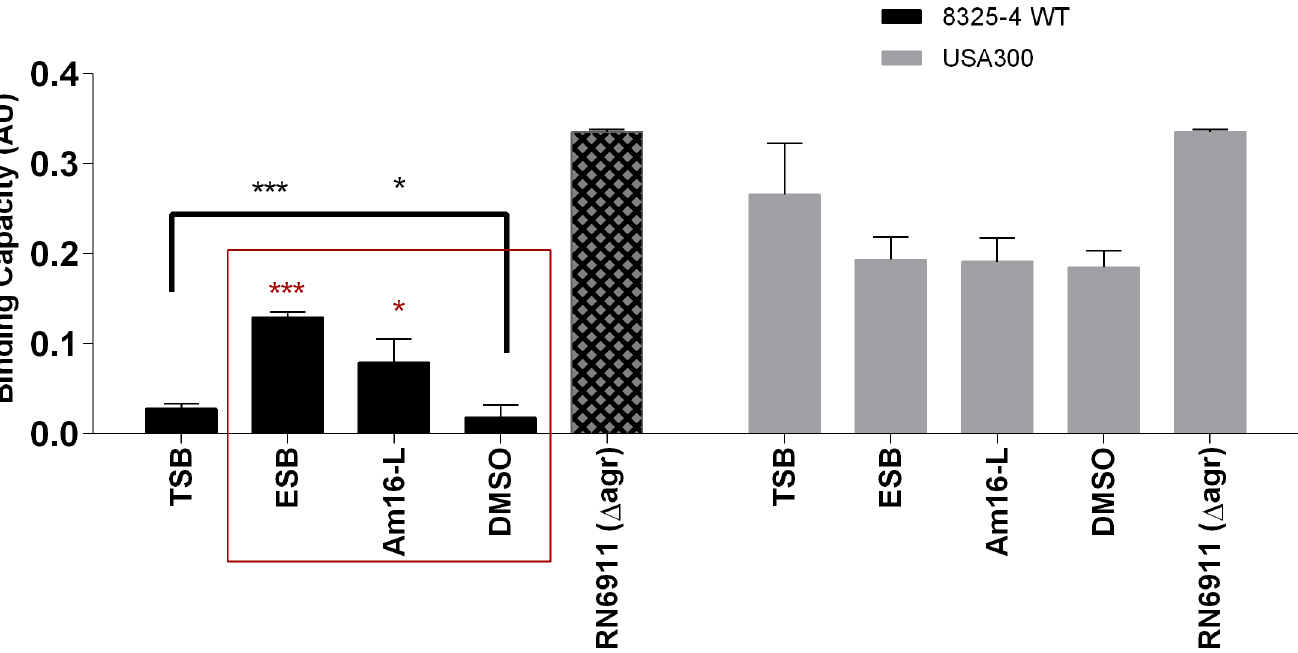
Fig 4. Solonamides marginally enhance adhesion to the extracellular matrix component fibronectin. Upon exposure of S . aureus strains to 10 μ g/mL anti-virulence compounds or vehicle control, attachment to fibronectin was measured in 96-well plates coated with 10 μ g/mL fibronectin and staining with 0.1% crystal violet. Absorbance values were corrected for cell density and represented as arbitrary binding units. For statistical significance, comparisons were made between untreated versus vehicle and treated (black bracket), and between vehicle control versus compound treated (red square). ns (no significance); * , p < 0.05; ** , p < 0.01; *** , p < 0.001.